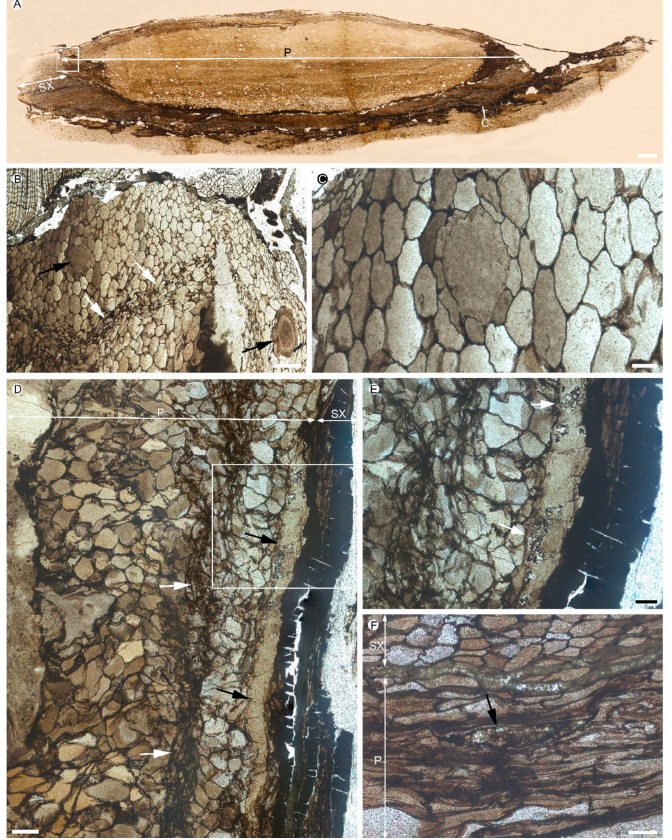
Figure 4. Gross morphology and the pith structures of the stem of Tingia unita from the Taiyuan Formation of Wuda Coalfield, Inner Mongolia. ( A – C , F ) Cross section of the stem. ( D , E ) Radial